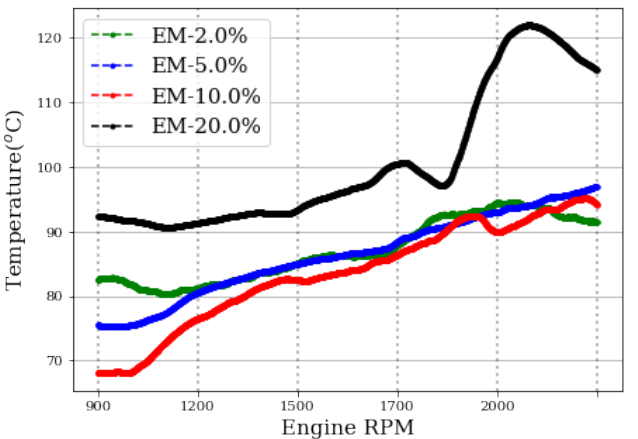
Figure 3. Exhaust temperature for different W/D emulsion compositions at increasing engine